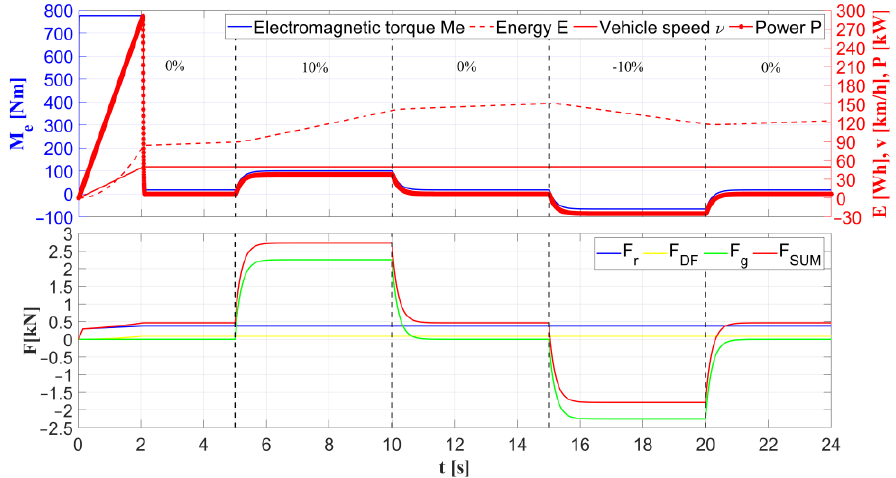
Figure 15. Driving cycle up and down for 2 × 146 kW IPMSM in